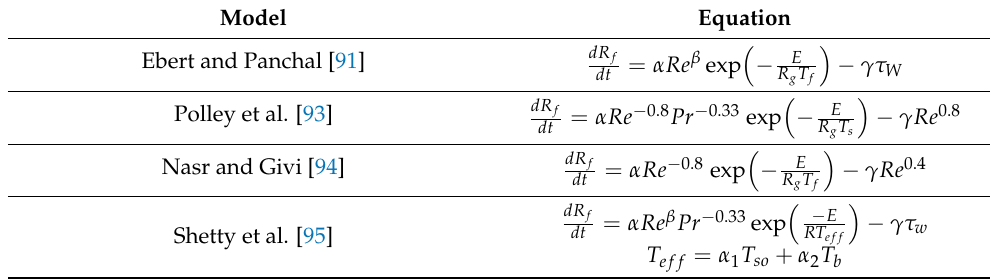
Table 2. Crude oil fouling prediction